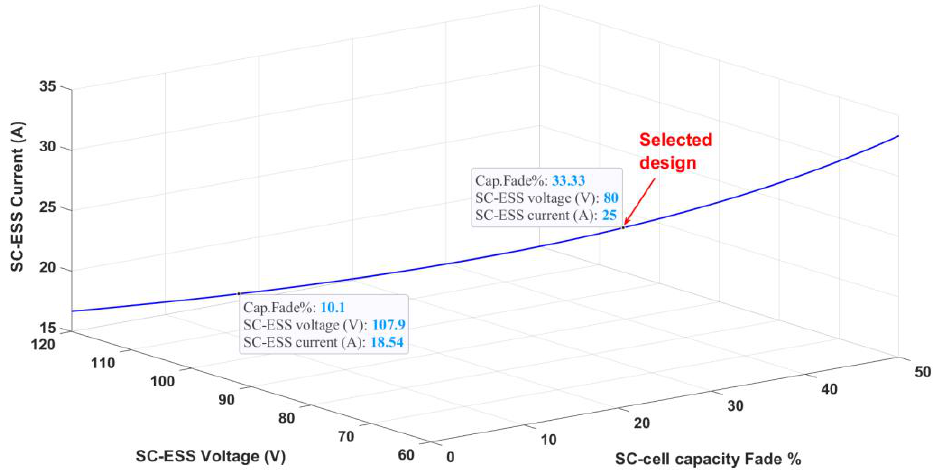
Figure 5. Illustration of how the individual SC cell capacity fades (%) impact the voltages and current levels of SC-ESS at which the corresponding shunt circuits of degraded cells need to be activated, considering 2 kW constant power charging